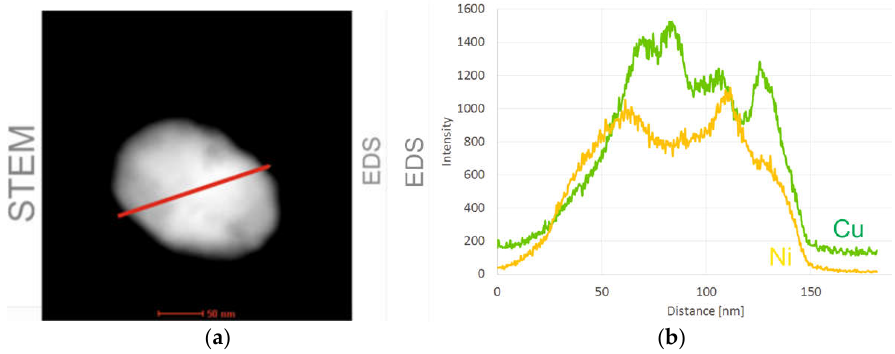
Figure 4. The component grain of CuXX illustrated by scanning transmission electron microscope method (STEM, Tecnai G2 F20, FEI, Krakow, Poland) ( a ), and analysis of content distribution of Cu and Ni on cut line (red line in STEM picture) ( b ).